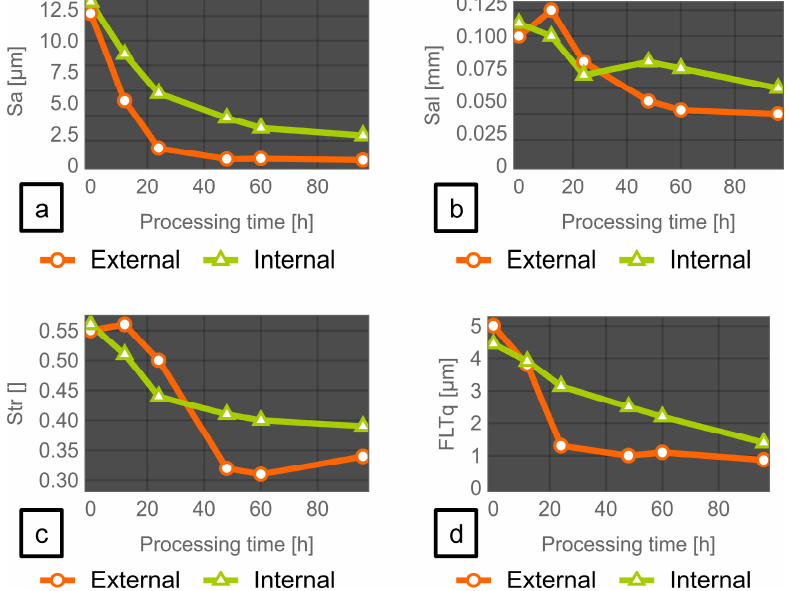
Figure 17. Trends of areal parameters for external and internal zones of the propeller for different BF working times: Sa ( a ), Sal ( b ), Str ( c ), and FLTq ( d ).